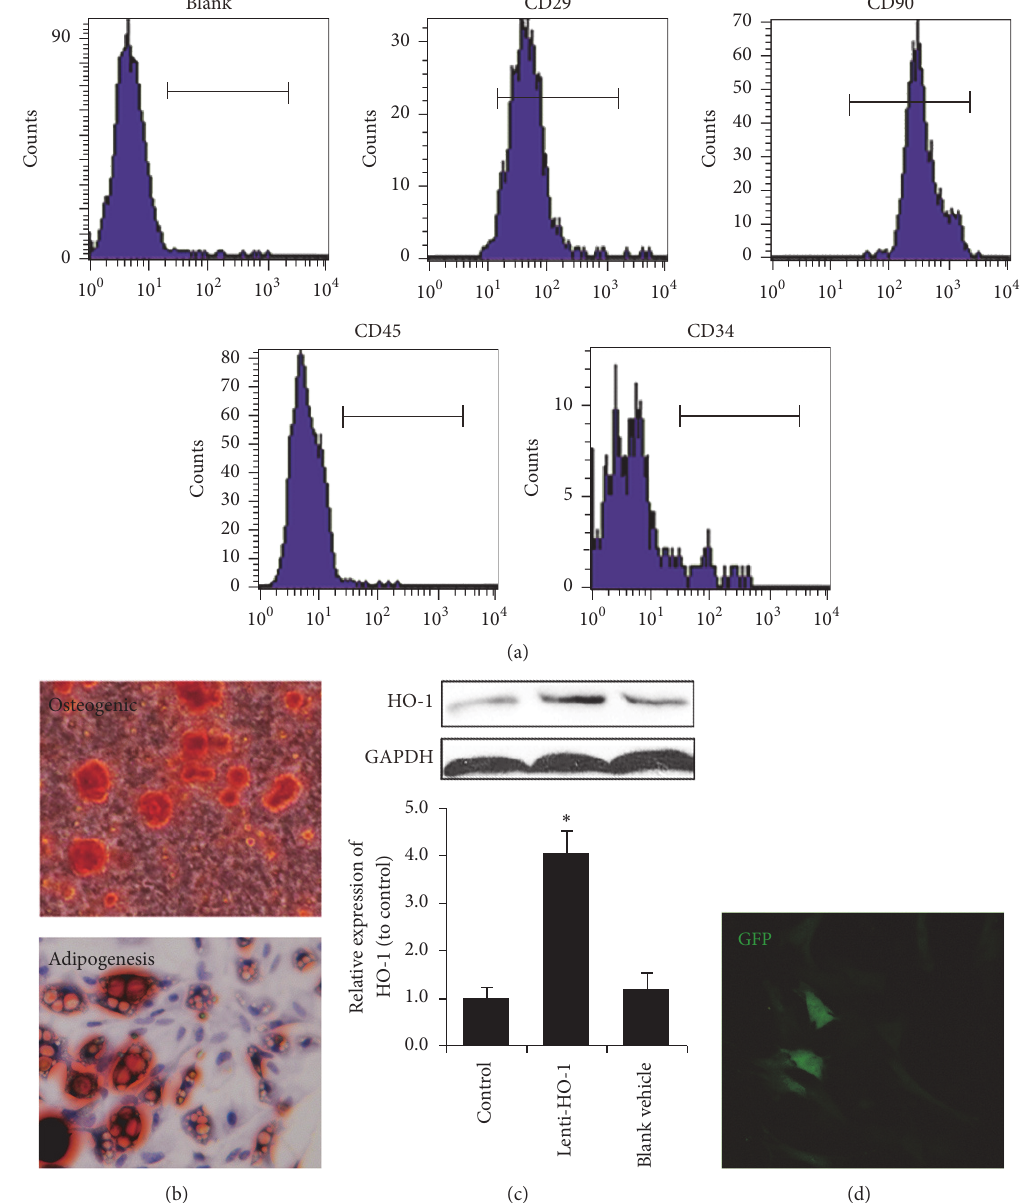
Figure 1: Characteristics of MSC and HO-1 transduction by lentiviral vectors. (a) Flow cytometry demonstrated that most MSC expressed CD29 and CD90 but less CD45 and CD34. (b) Multipotency of MSC, differentiating into adipocytes stained by Oil Red O and osteocytes stained by Alizarin Red S. (c) HO-1 expressions in control and MSC transduced with lenti-HO-1 and blank vehicle, 𝑛 = 5 . (d) GFP image of MSC after transduction by lentiviral vectors. ∗ 𝑃 < 0.01 compared with